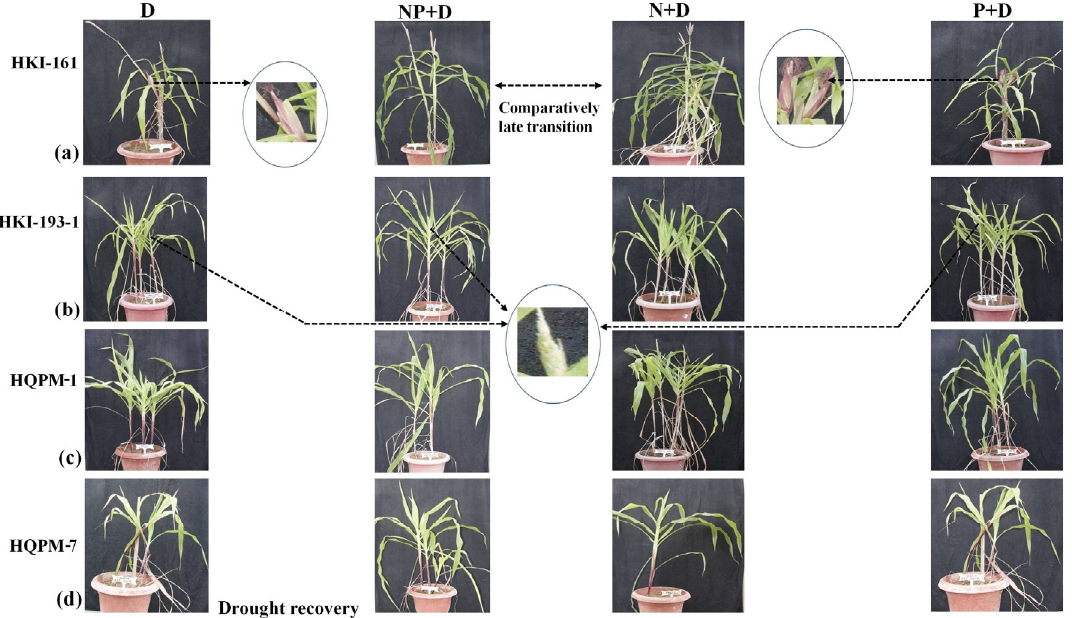
Figure 7. Representative pictures of maize seedlings showing drought recovery. The seedlings were exposed to stress for 17 days and then watered for one week to monitor recovery. The different lanes represent ( a ) HKI-161, ( b ) HKI-193-1, ( c ) HQPM-1 and ( d ) HQPM-7 genotypes. The panels in each lane include the seedlings exposed to drought stress alone or drought stress in presence of nitrogen (N) and phosphorous (P) in combination (NP) or individually (N or P).